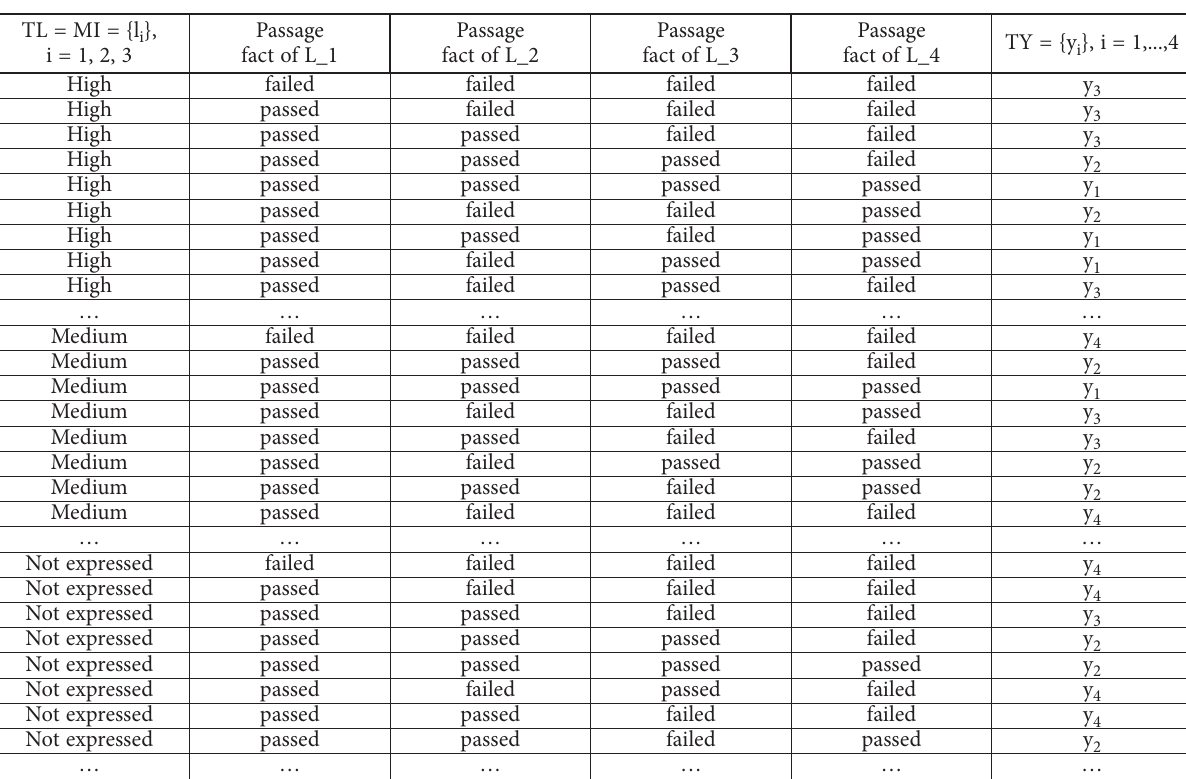
Table 2. The rules base fragment of the fuzzy knowledgebase FIS k ( k = 1, K